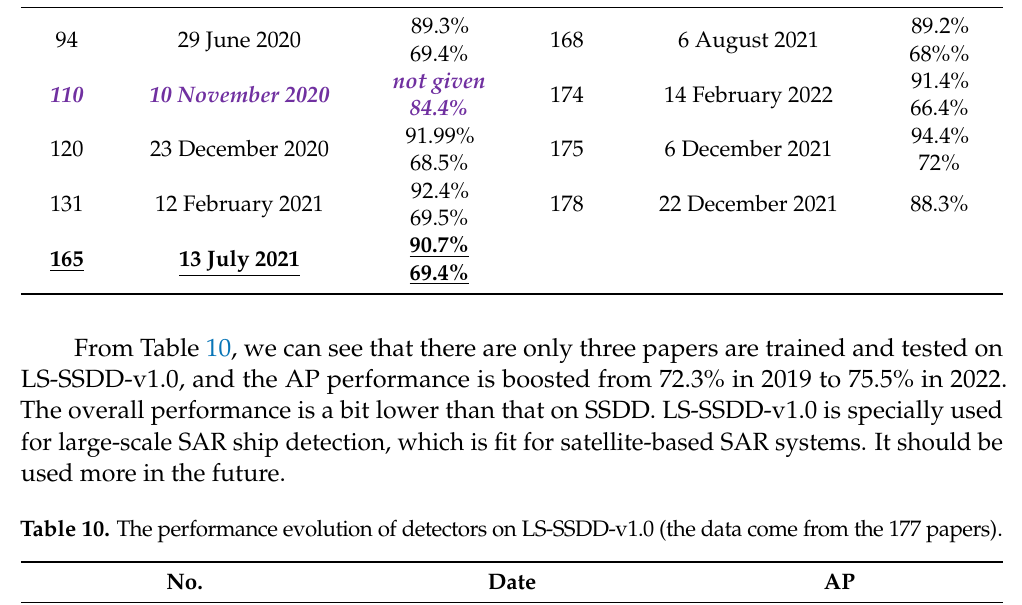
Table 9. The performance evolution of detectors on HRSID (the data come from the 177 papers). No.